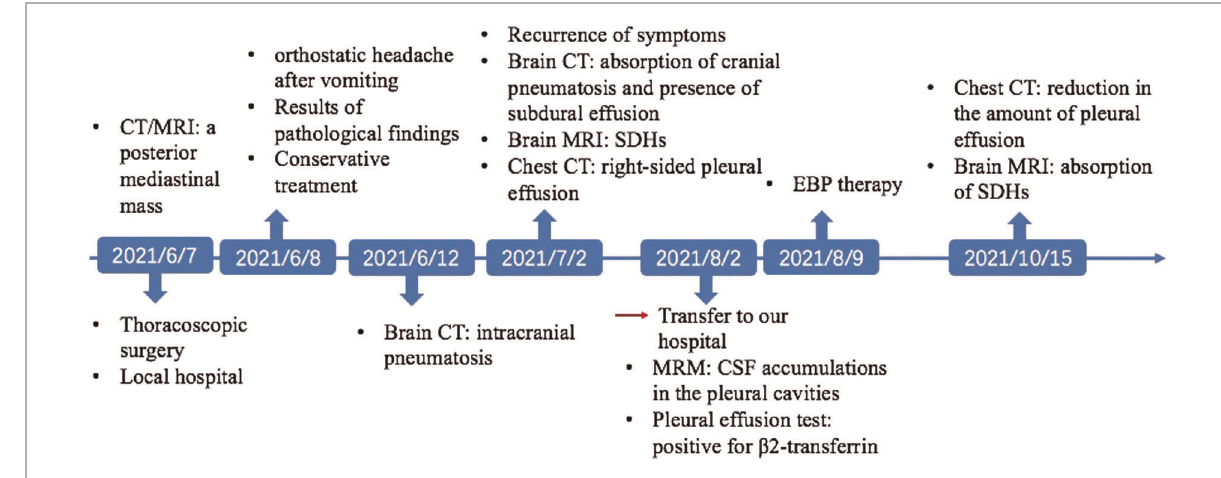
FIGURE 3 Timeline of the patient ’ s clinical